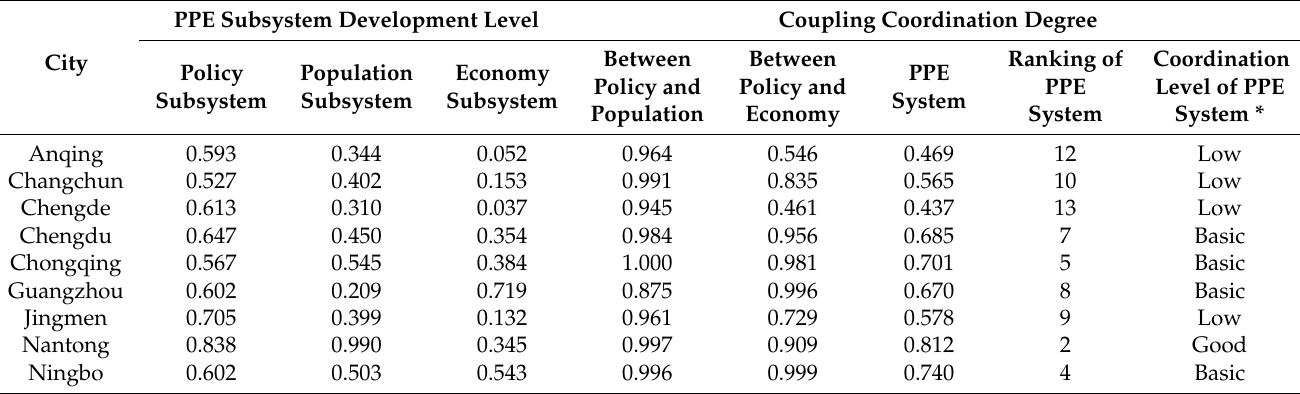
Table 4. Development level and coupling coordination degree of the LTCI PPE system in 14 pilot